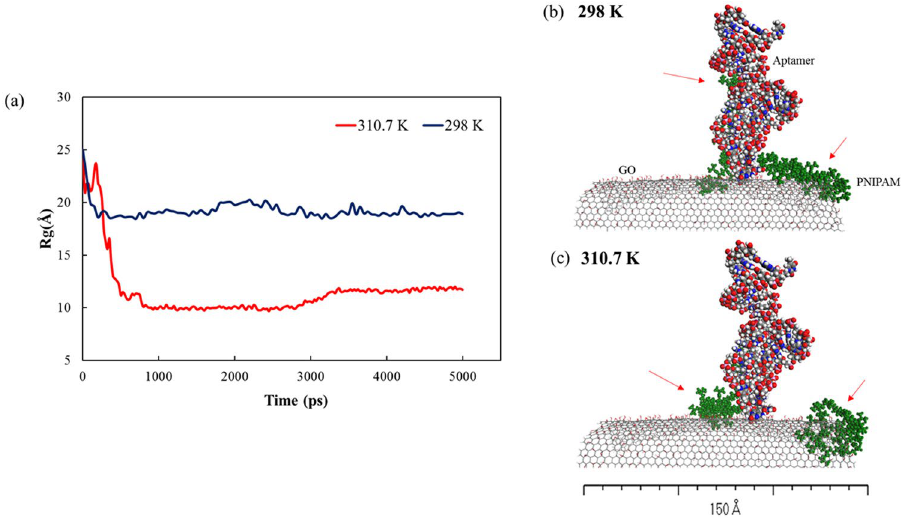
Figure 3. ( a ) Radius of gyration of the grafted PNIPAM on the System I at temperatures of 298 K (blue line) and 310.7 K (red line). The MD snapshots of the grafted PNIPAM in System I (green molecules) with behavior checked after MD simulations at ( b ) 298 K and ( c ) 310.7 K. These explain the natural properties of PNIPAM which are coiled under LCST and collapsed above